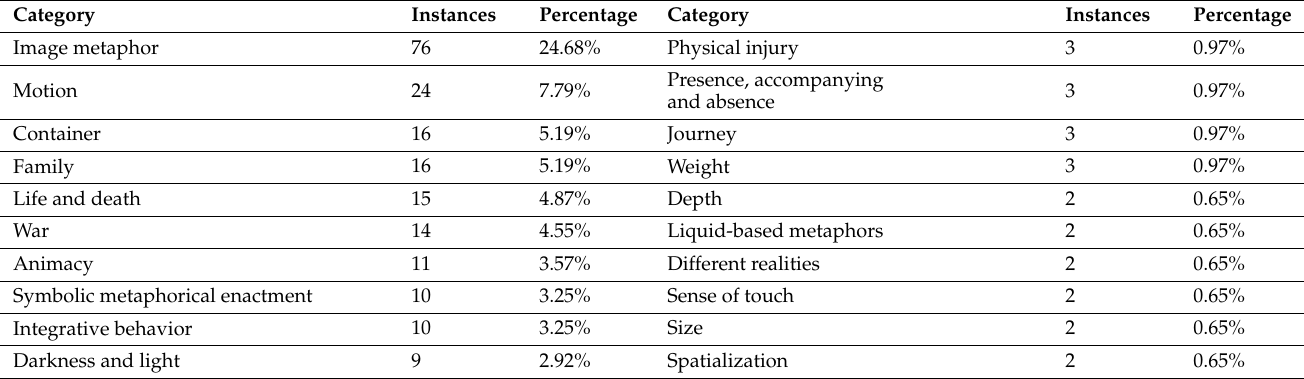
Table 2. The categories of metaphorical